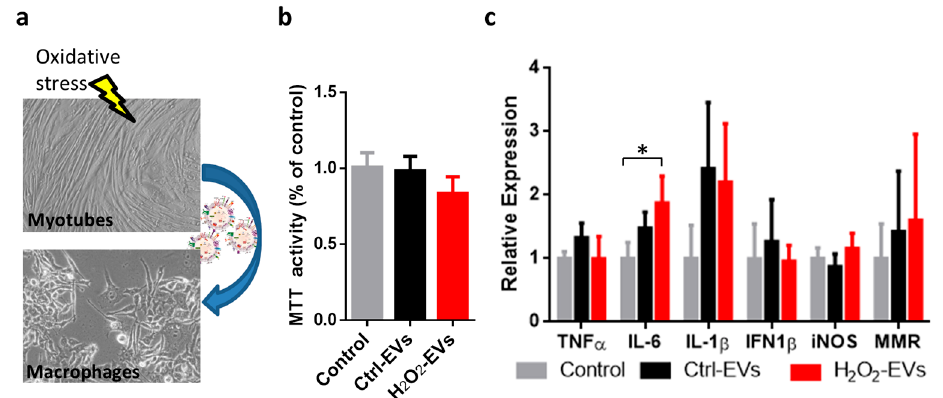
Figure 4. Treatments of RAW264.7 macrophages with EVs released by myotubes following oxidative challenge. The blue arrow indicates the addition of myotube-derived EVs to RAW264.7 cells. RAW264.7 macrophages were treated using 1 × 10 10 particles/mL from control (Ctrl-EVs) or oxidatively injured (H 2 O 2 -EVs) myotubes ( a ); MTT cell viability assay ( b ) and mRNA expression ( c ) analyses were performed 24 h after EV treatments. The results are represented as mean ± SD; n = 4; * p < 0.05.